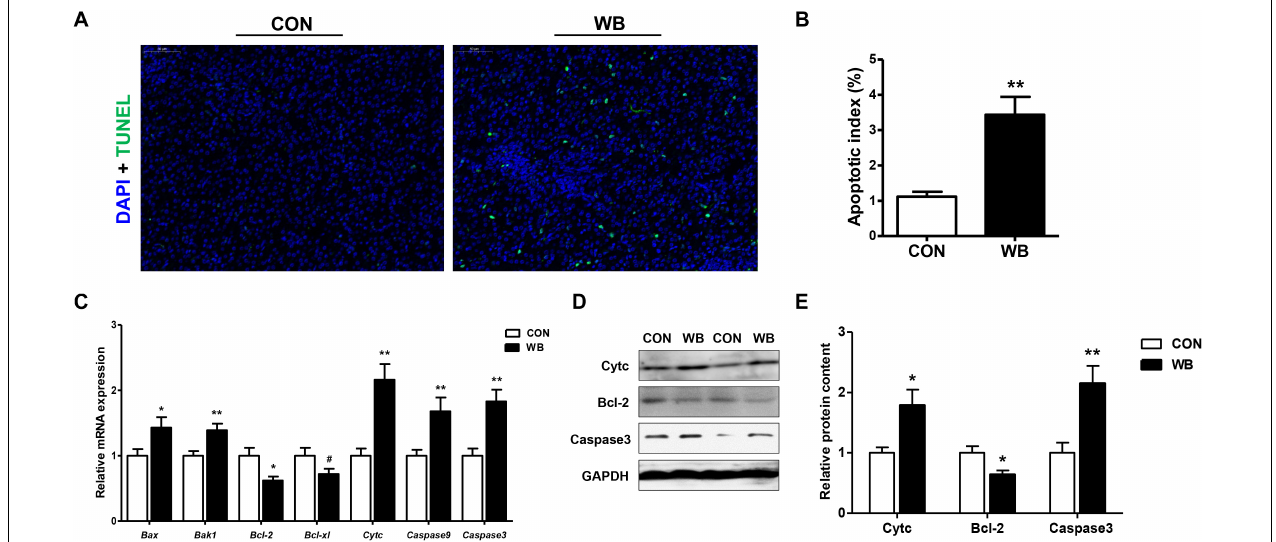
FIGURE 3 | Apoptotic status and apoptosis-related mediators in the liver tissues of broiler chickens with normal (CON) and wooden breast (WB) pectoralis major muscle. (A) Representative images of terminal deoxynucleotidyl transferase-mediated dUTP nick-end labeling (TUNEL) staining of liver. (B) Relative percentage of hepatocyte apoptosis. (C) Relative mRNA expression of Bcl-2-associated X protein (Bax), Bcl-2 antagonist or killer 1 (Bak1), B cell lymphoma (Bcl)-2, Bcl-xl, cytochrome c (Cytc), caspase 9, and caspase3. (D) Representative Western blotting images of Cytc, Bcl-2, and caspase 3. (E) Relative protein content of Cytc, Bcl-2, and caspase 3. Data are expressed as the mean ± SE ( n = 10). ** P < 0.01, * P < 0.05, and # 0.05 < P < 0.1.